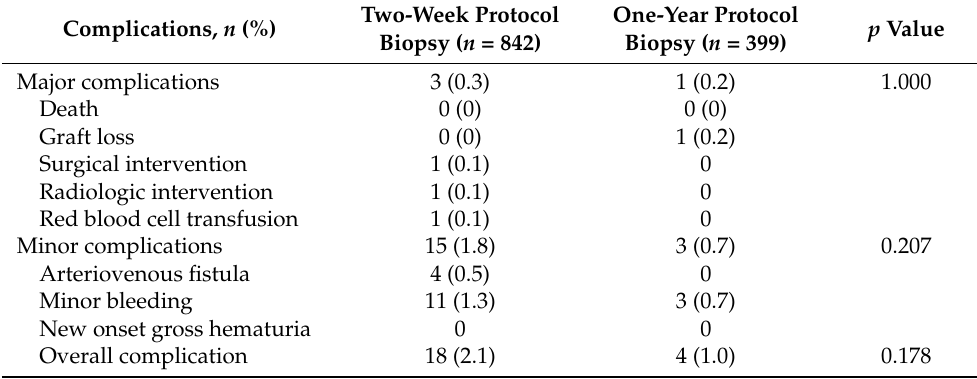
Table 3. Complication rates of protocol biopsies in renal